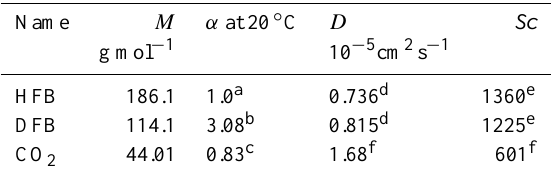
Table 1. Molar mass, solubility, diffusivity in water and Schmidt numbers of the tracers hexafluorobenzene (HFB) and 1,4- difluorobenzene (DFB) for a temperature of 20 ◦ C. Also shown is CO 2 for comparison.